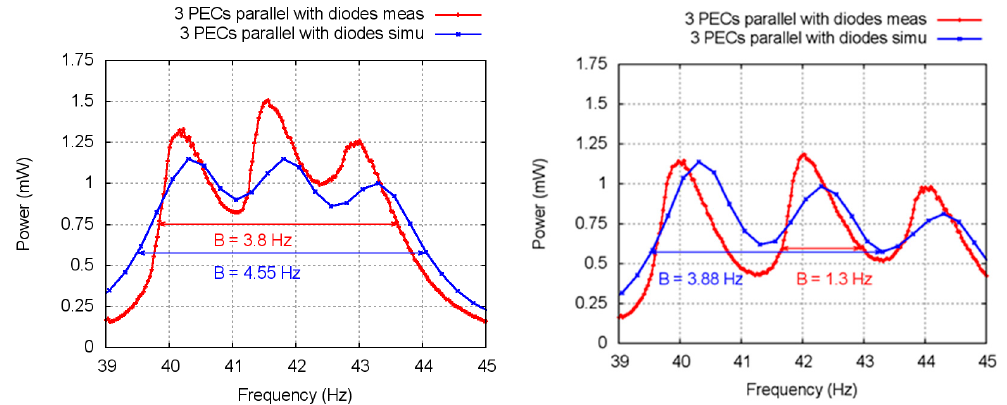
Figure 14. Comparison of the simulated and measured power with dependence upon frequency for the parallel connection of two PECs with individual rectifiers and ∆ f = 1.5 Hz ( left ) or ∆ f = 2 Hz ( right ).